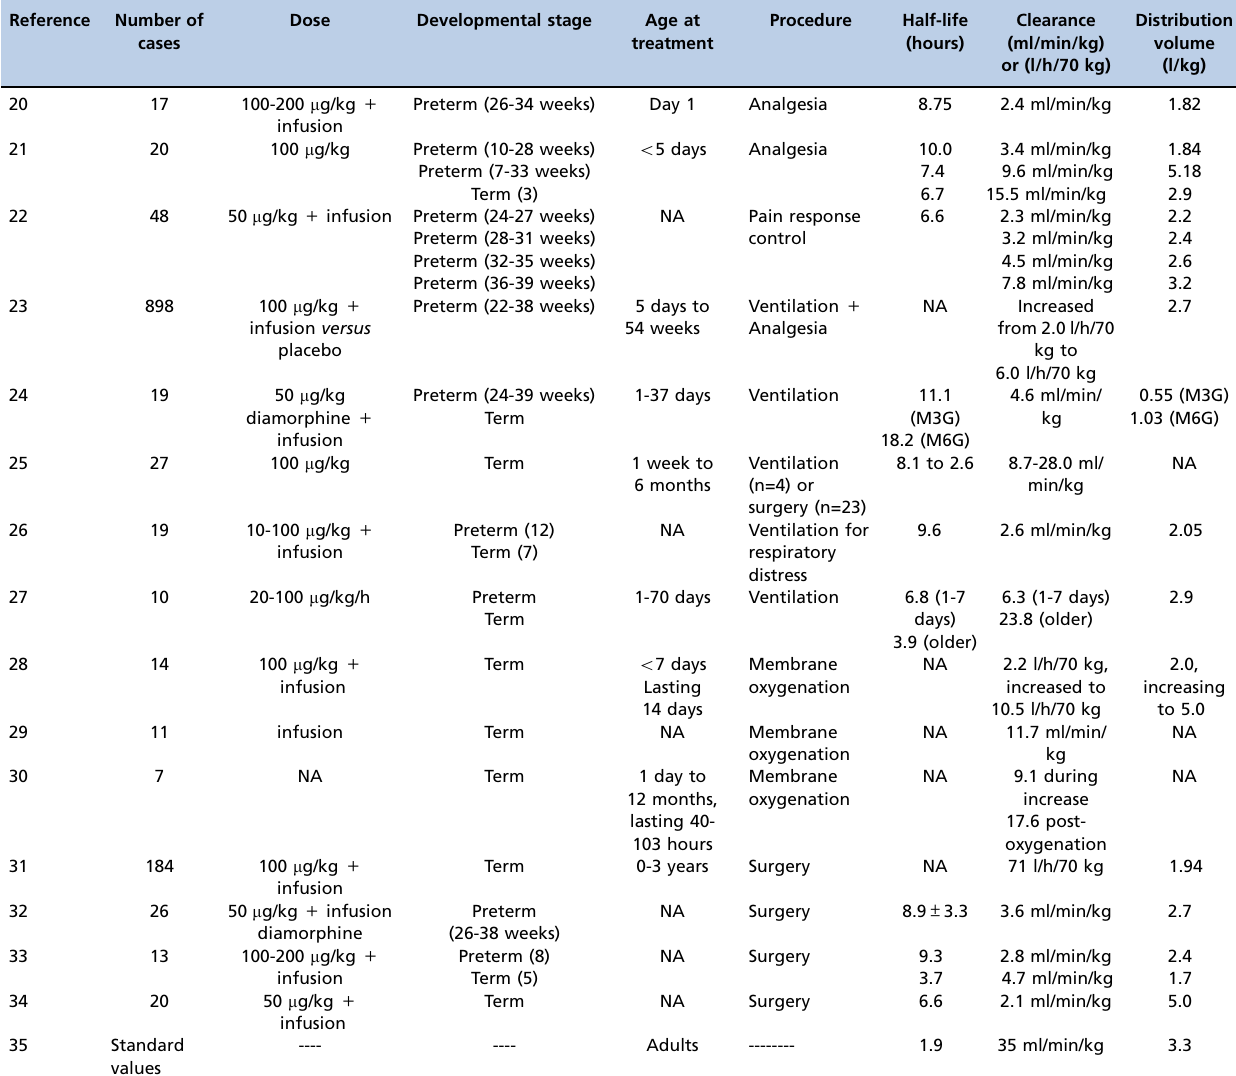
Table 2 - Demographic and pharmacokinetic parameters of morphine in neonates. The figures are means. The adult values (34) are normal and are used for comparison. Reference Number of